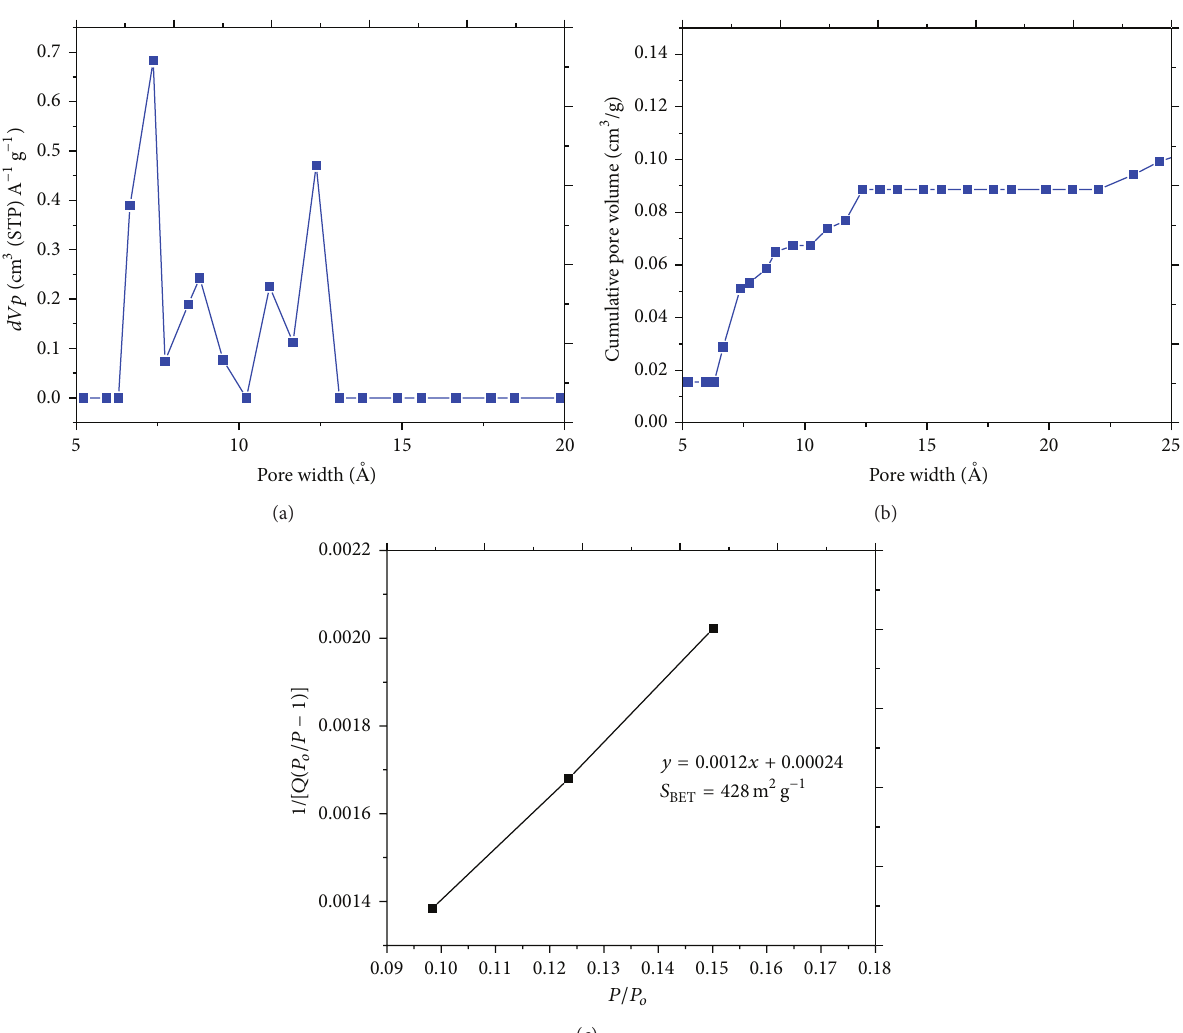
Figure 7: Differential (a) and cumulative (b) pore size distribution plot of PyP from the application of the NLDFT model to N 2 isotherm. BET plot (c) for PyPcalculated from isotherm data.